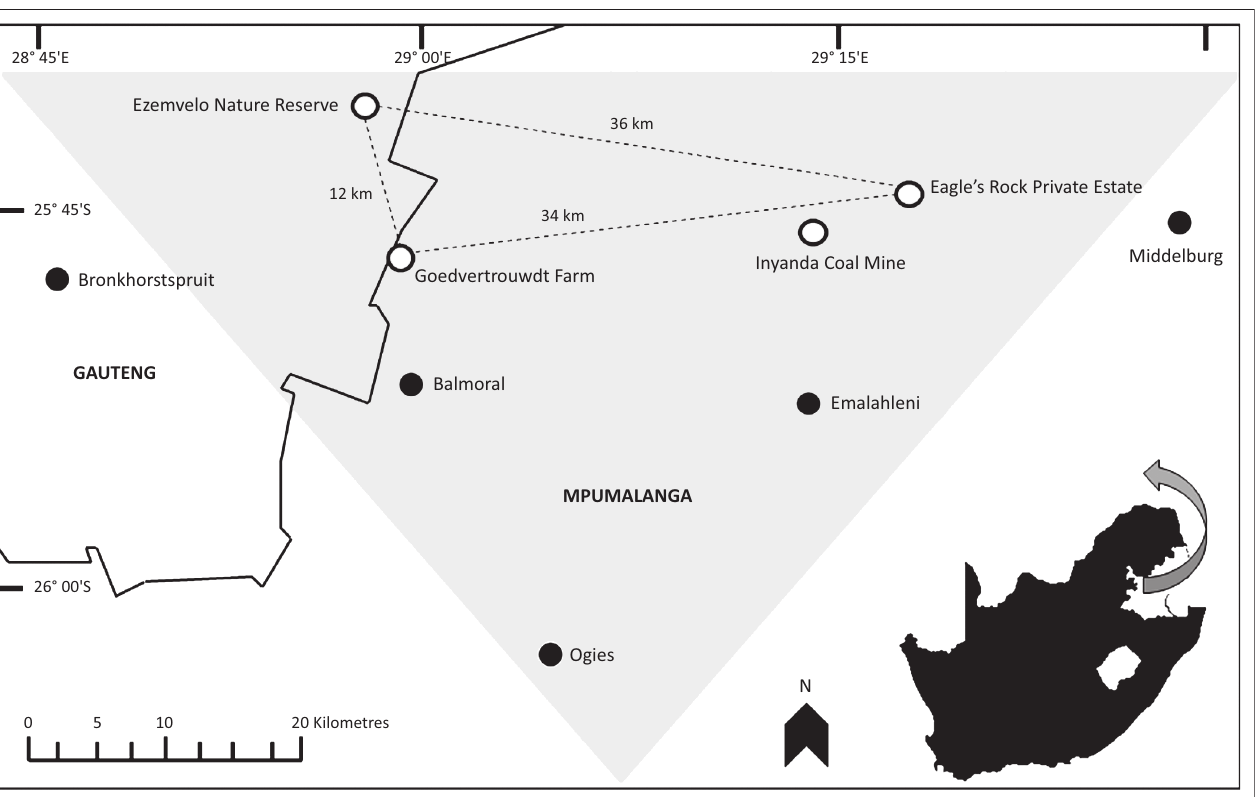
FIGURE 3: Localities of the receptor sites (Ecca sandstone at Goedvertrouwdt Farm and sedimentary rock at Eagle’s Rock Private Estate) and control population at Ezemvelo Nature Reserve on Ecca and Dwyka sandstone in South Africa. The donor population at Inyanda Coal Mine is indicated and the shaded grey triangle represents the approximate endemic distribution of Frithia humilis . Distances between study populations are indicated.